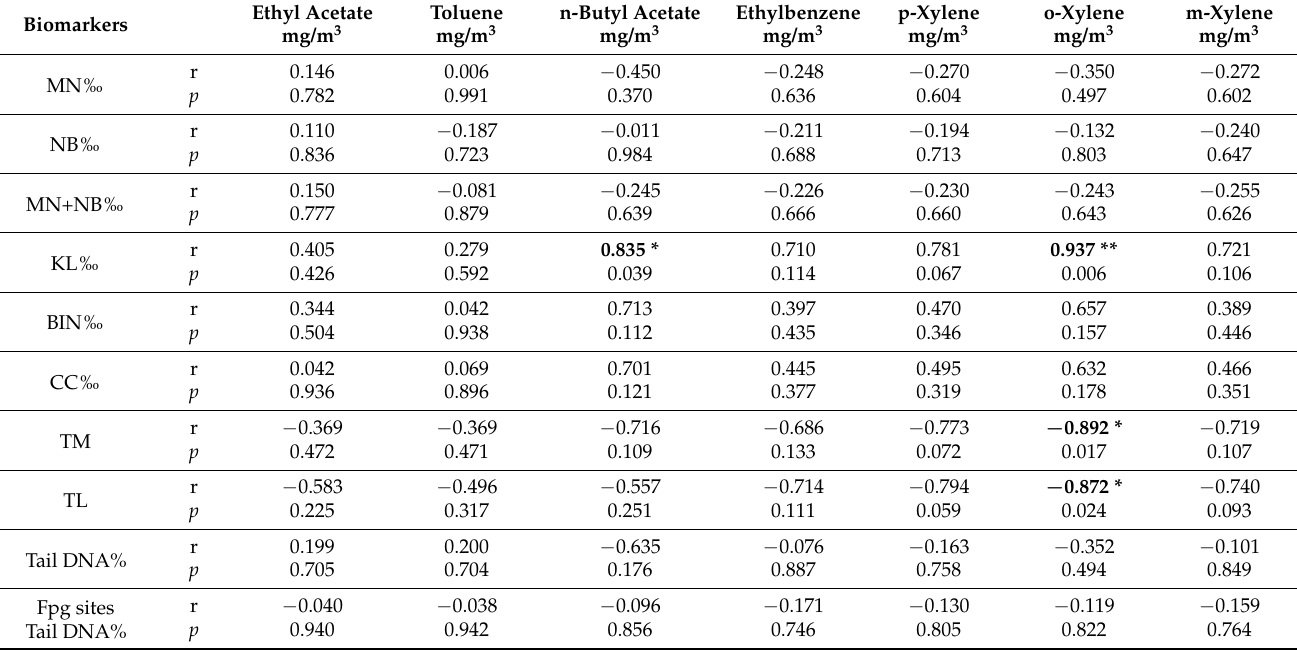
Table 6. Pearson’s correlation analysis between (VOCs) and biomarkers of effect in the spray workers. Biomarkers